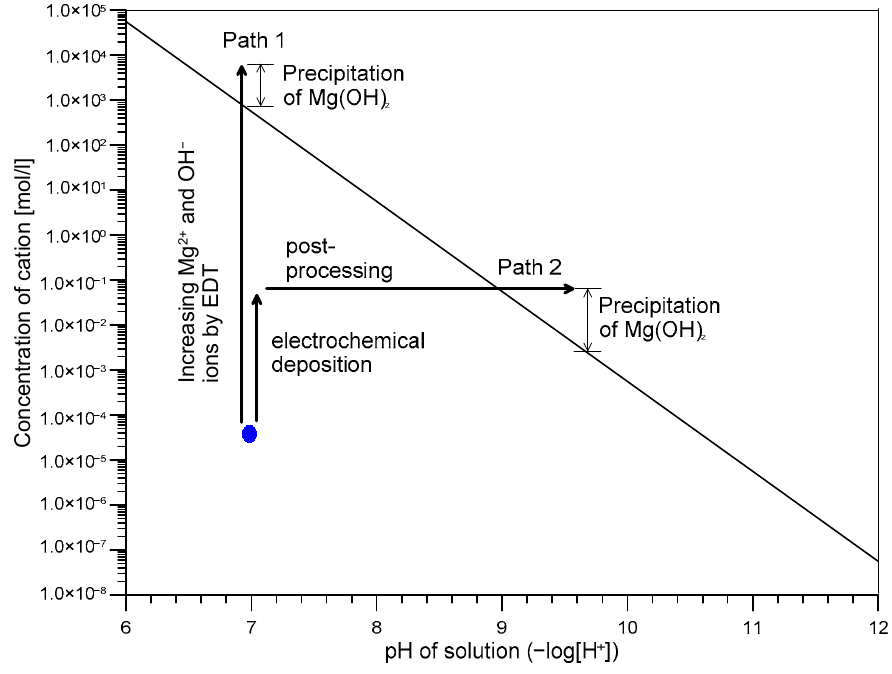
Figure 15. Relationship between the concentration of Mg 2+ and the pH of the solution. However, a conventional EDT process used in the experimental phases 1 and 2 was not effective for repairing (closing or filling) a surface-breaking crack in concrete samples in this study. It can be attributed to several reasons: (1) pH drop around cracks in concrete after formation of a surface-breaking crack during the accelerated corrosion test, (2) migration of (OH) − ions toward the external anodic electrode during the EDT processes, and (3) pH drop in an external electrolyte due to the migration of OH − . It seems that only two weeks was not sufficient for conventional EDT method to work. In this study, it was found that the post treatment process with a NaOH solution is effective for facilitating the precipitation of Mg 2+ ions through the 2nd path in Figure 15. In this light, it is not recommended to expose the repairing concrete to high alkalinity before EDT. For example, in the case of EDT process 4, the concrete specimen was treated by NaOH solution (pH 13) prior to the main electrochemical process. White precipitations were more concentrated around crack mouth, which could impede electro-deposition current flows. Consequently, less precipitations were observed around the crack tip compared to the other three concrete specimens without the pre-treatment